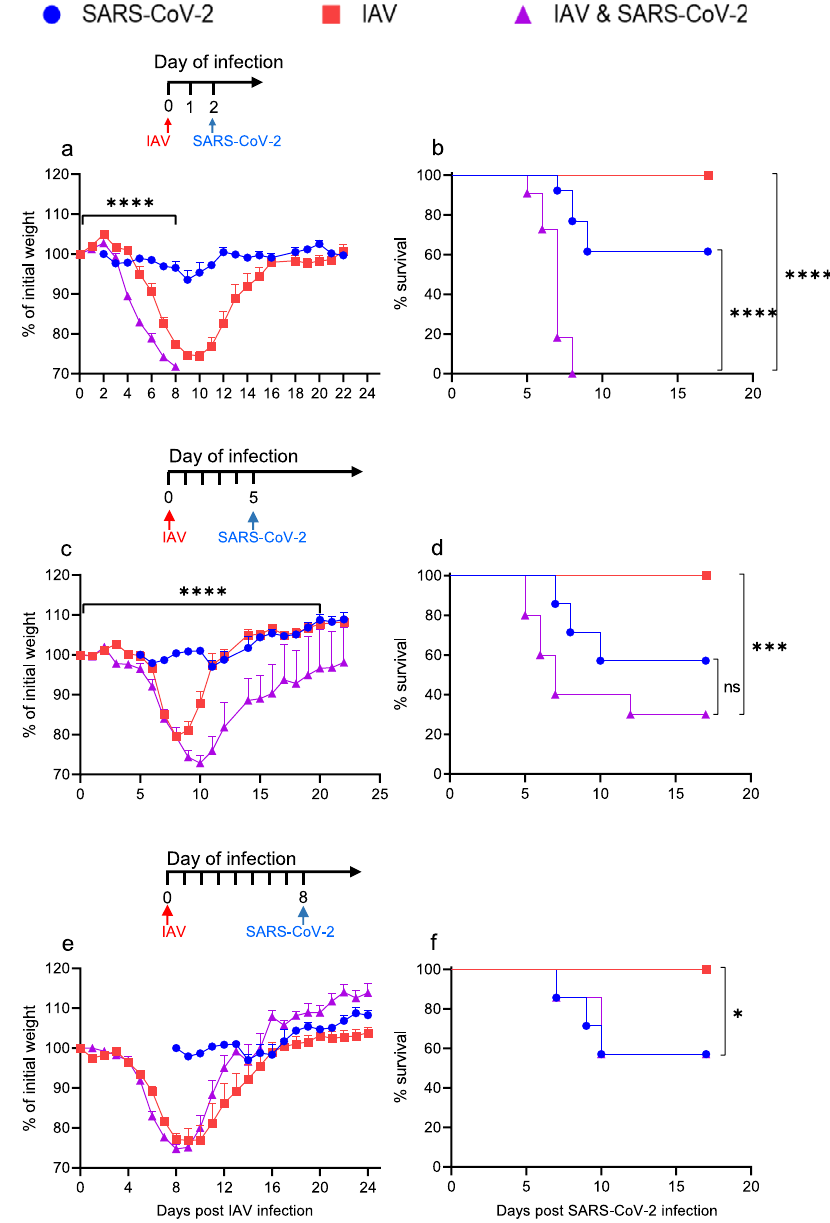
Fig. 1 Morbidity and mortality in K18-hACE2 mice infected with SARS-CoV-2 following in fl uenza infection. K18-hACE2 mice were infected with IAV (80PFU/mouse, i.n.), followed by infection with SARS-CoV-2 (10PFU/mouse, i.n.) at 2 ( a , b ), 5 ( c , d ), or 8 ( e , f ) dpIi. The percent weight loss following infection is shown ( a , c , e ). The red arrow represents IAV infection. The blue arrow represents SARS-CoV-2 infection. All measurement data are expressed as mean + standard error (SE). The area under the curve (AUC) was calculated using GraphPad Prism 8.4.3; IAV infection compared to coinfection ( a , c , e ); **** p < 0.0001 ( a , c ), ns ( e ). Survival curves are shown ( b , d , f ): * p = 0.0453; *** p = 0.0007; **** p < 0.0001; IAV or SARS-CoV-2 infection compared to coinfection. ns, not signi fi cant ( p = 0.0779), log-rank test (Mantel-Cox). The fi gure shows one representative experiment of 4 ( a , b ), 2 ( c , d ), and 1 ( e , f ) experiments performed. The fi gure includes the IAV-infected group, which consisted of 10 ( a , b ), 11 ( c , d ), or 8 ( e , f ) mice; the SARS-CoV-2-infected group, which consisted of 13 ( a , b ) or 14 ( c – f ) mice; and the coinfection group, which consisted of 11 ( a , b ), 10 ( c , d ), or 7 ( e , f )